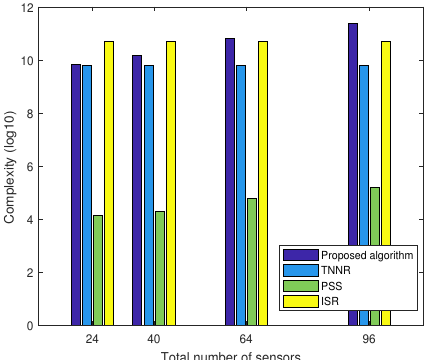
Figure 4. Complexity comparison versus the total number of